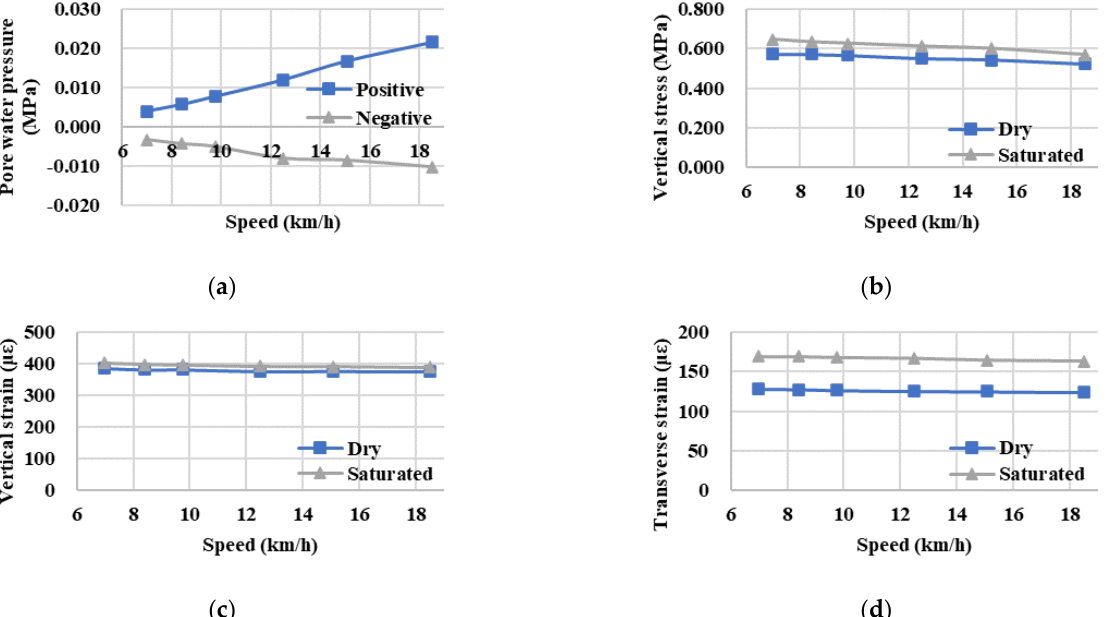
Figure 13. Variations of dynamic response magnitudes with vehicle speed obtained from field tests (controlling vehicle load at 0.7 MPa): ( a ) Pore water pressure; ( b ) Vertical stress; ( c ) Vertical strain; ( d ) Transverse strain.